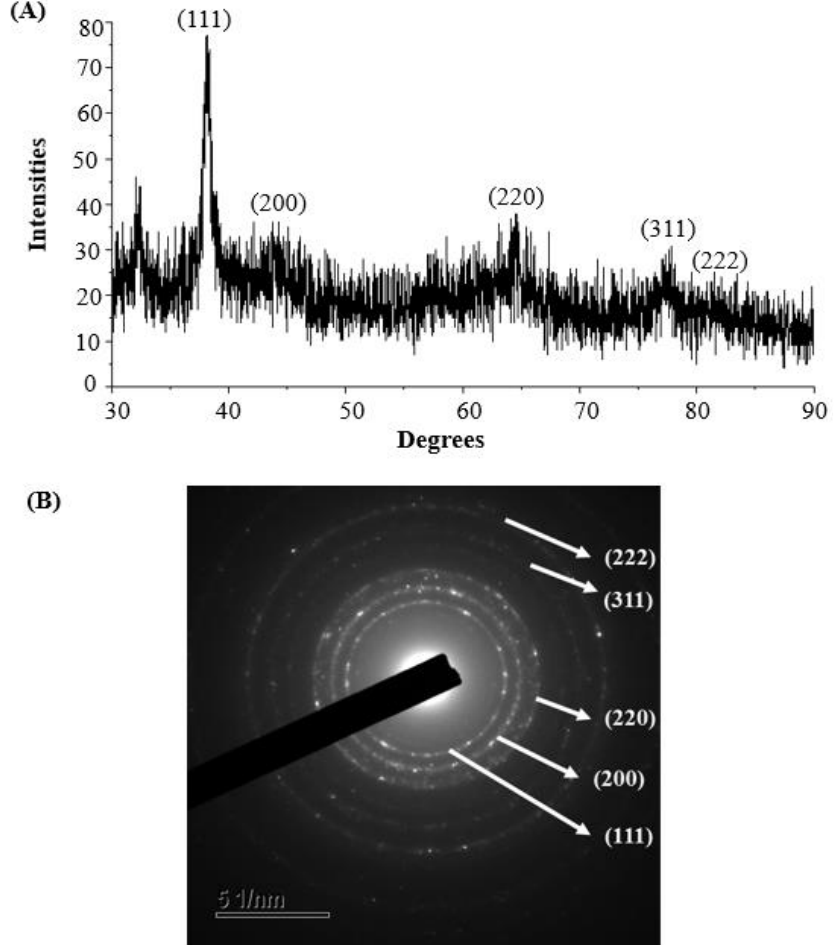
Figure 4. XRD pattern ( A ) and SAED pattern ( B ) of probiotic-mediated synthesized AgNPs. FTIR analysis revealed that different functional groups surrounded the biosynthe- sized AgNPs (Figure 5A). The FTIR pattern of AgNPs had several peaks at 3272.36 cm –1 , 2917.11 cm –1 , 2849.12 cm –1 , 2115.72 cm –1 , 1737.37 cm –1 , 1633.76 cm –1 , 1538.72 cm –1 , 1454.03 cm –1 , 1374.76 cm –1 , 1212.81 cm –1 , and 1031.17 cm –1 . The band found at 3272.36 cm –1 was attributed to O–H (alcohol) and/or N–H (amine) stretching. The bands at 2917.11 and 2849.12 cm –1 were attributed to C–H (alkane) group. The peaks observed at 2115.72 cm –1 were attributed to the N=C=S (isothiocyanate) stretching. The peak found at 1737.37 cm –1 represented the C=O ( α , β -unsaturated ester) stretching. The peaks at 1633.76, 1538.72, and 1454.03 cm − 1 were attributed to C=C (olefin) stretching, N-O (nitro compound) stretching, and methyl group C–H (alkane) bending, respectively. The peak observed at 1374.76 cm –1 represented the O-H (phenol) bending. The bands at 1212.81 cm –1 and 1031.17 cm –1 were attributed to C-O (alkyl aryl ether) stretching and S=O (sulfoxide) stretching, respectively. The FTIR spectrum indicated that the functional molecules including biopolymers such